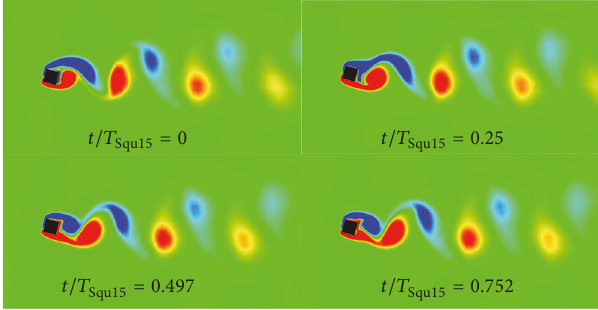
Figure 17: Vortex structures in synchronization region for 𝛼 = 0 ∘ .